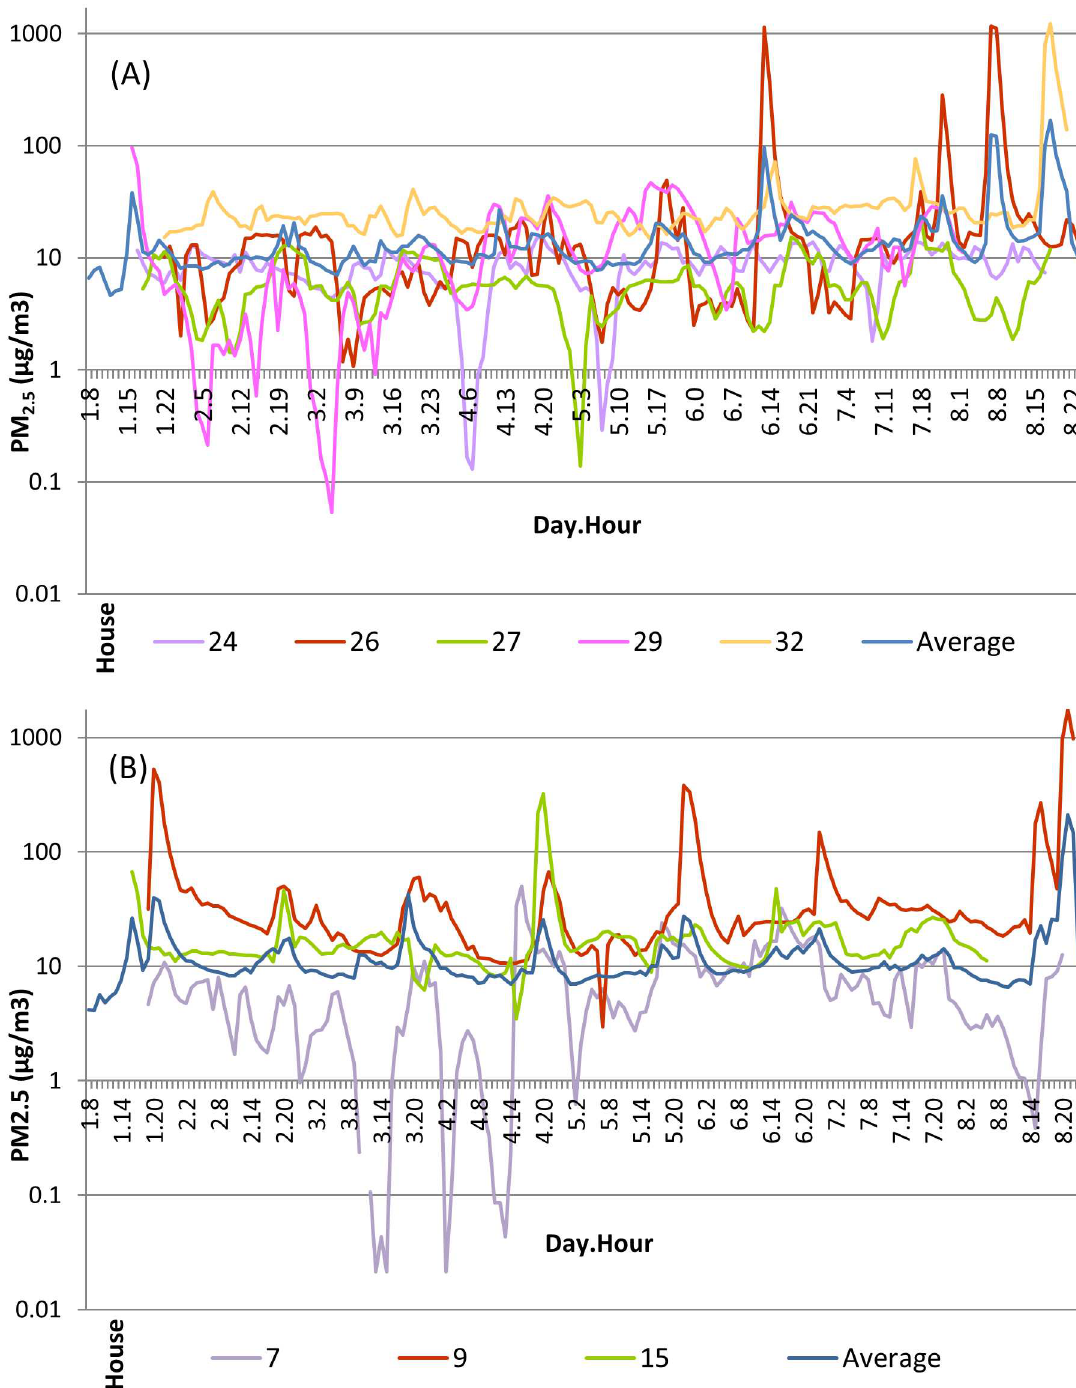
Fig 1. Mean Hourly PM 2.5 Concentrations AcrossStudy Time Period for Select Homes With Wood Stove Use (Panel A) and Without Wood Stove Use (Panel B). Mean hourly PM 2.5 concentrations for homes selectedfor exhibiting peaks in PM 2.5 concentrations (2 homes with wood stove use and 2 homes without wood stove use) or dips in PM 2.5 concentrations (3 homes with wood stove use and 1 home without a wood stove use). Hourly PM 2.5 concentrations averaged across homes with wood stove use (N = 14 homes) and without wood stove use (N = 22 homes) are also displayed. S1 Fig shows mean hourly PM 2.5 concentrations for every